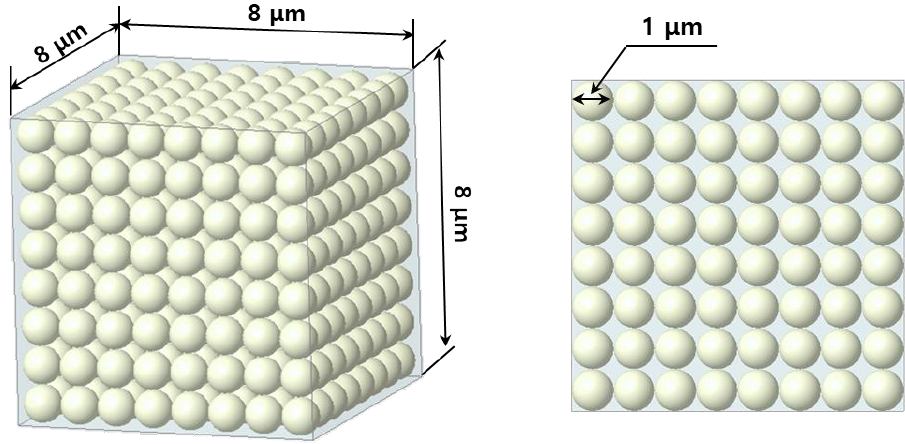
Figure 8. Theoretical arrangement of AP particles in the space of RVE model.